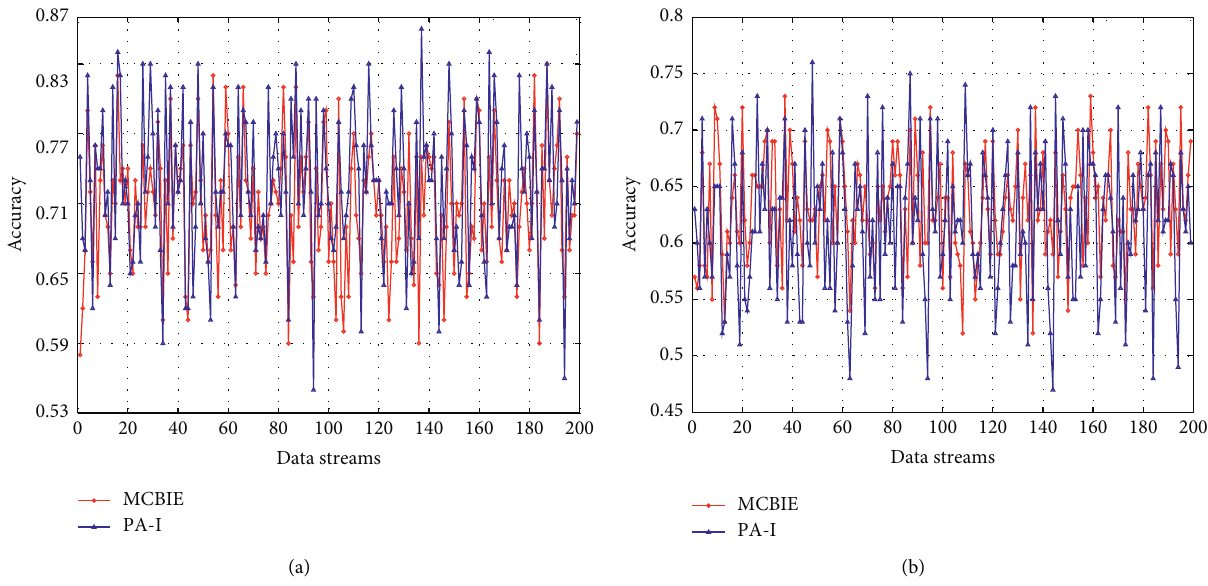
Figure 8: The accuracy curve for the two best methods over SEA data streams. (a) SEA with 20% noise. (b) SEA with 30%